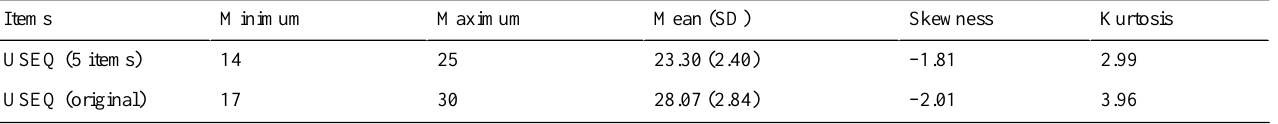
Table 6. Scores obtained on the User Satisfaction Evaluation Questionnaire for the original scale with 6 items and the newly proposed scale with 5 items.